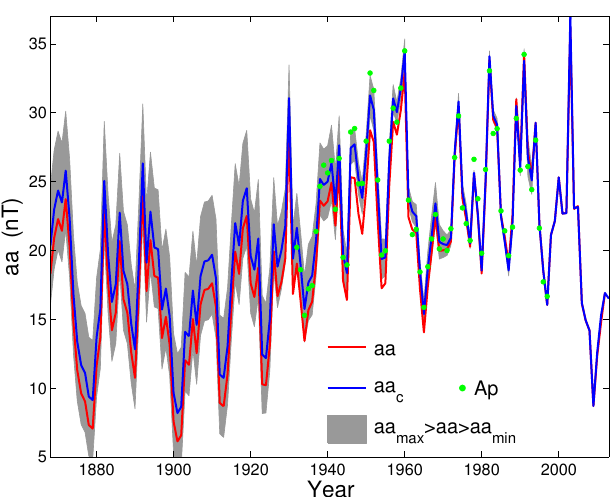
Figure 5: Comparison of annual means of the standard 𝑎𝑎 index (in red) and the modified version 𝑎𝑎 𝐶 derived by Lockwood et al. (2006b) (in blue). The estimated maximum uncertainty, relative to modern values, is shown by the grey band. The green dots are annual means of the 𝐴𝑝